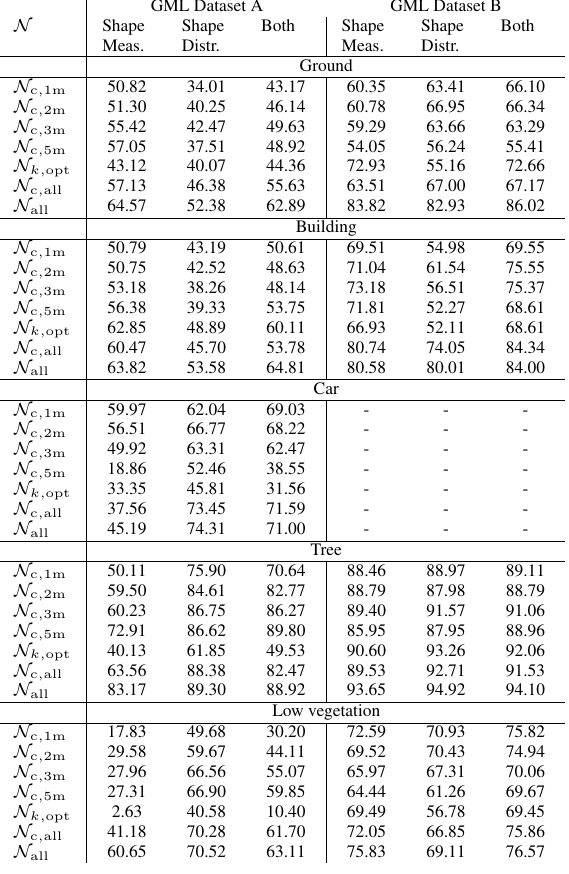
Table 7. Class-wise PREC (in %) for different neighbourhood definitions and different feature